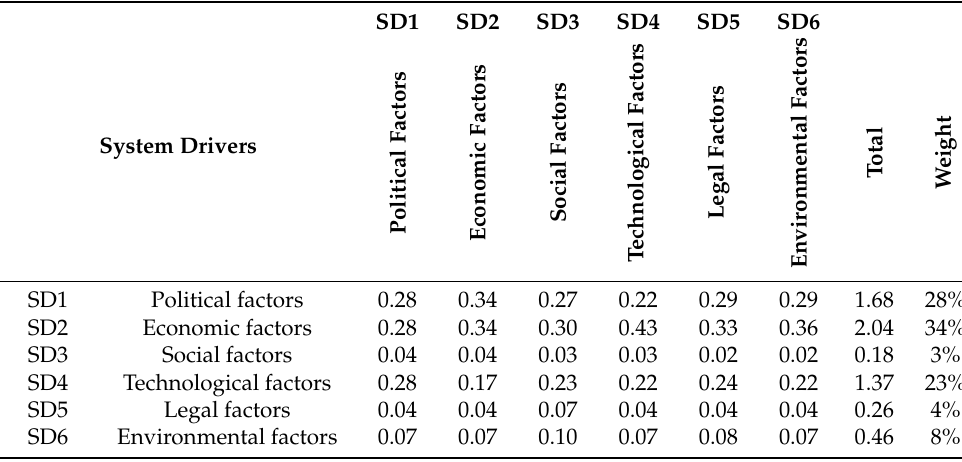
Table A1. System Drivers (SD) for Utility-scale